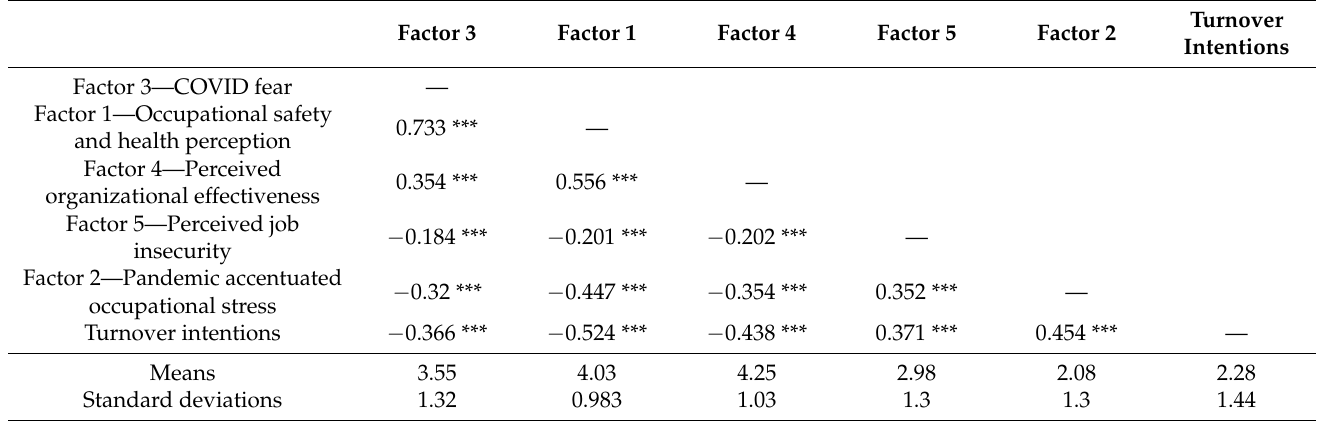
Table 1. Correlations between the scale’s 5 factors and turnover intentions.